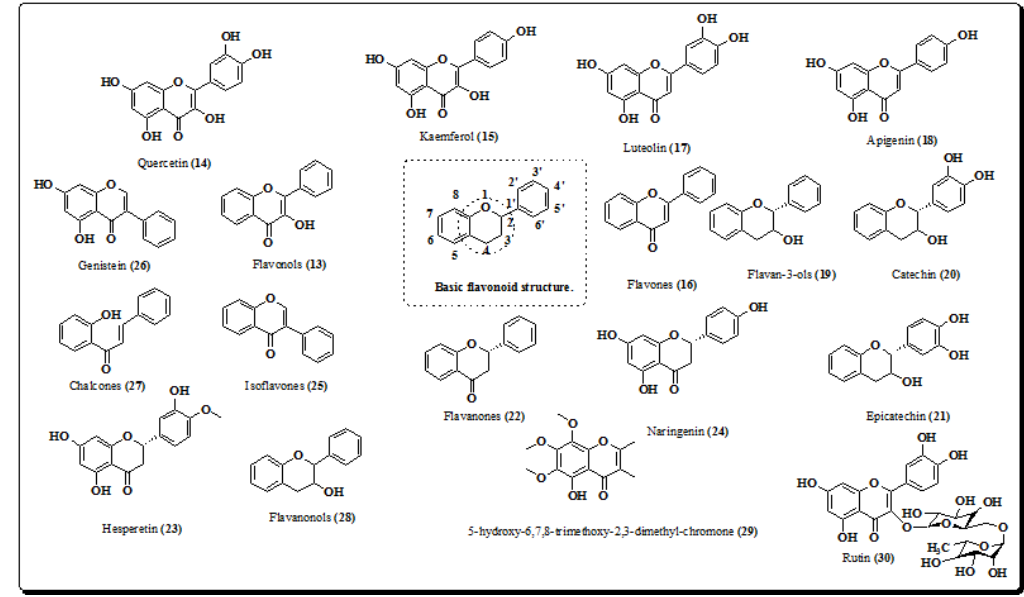
Figure 3. Structures of flavonoids from E. laevis. ( 13 – 30 )